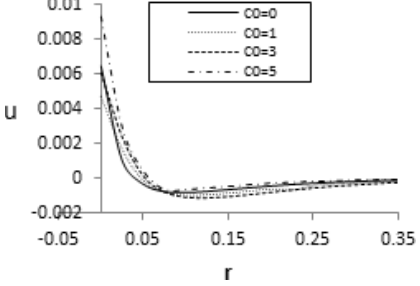
Figure 5: Distribution of displacement stress with the radius via RPL ℜ = 4